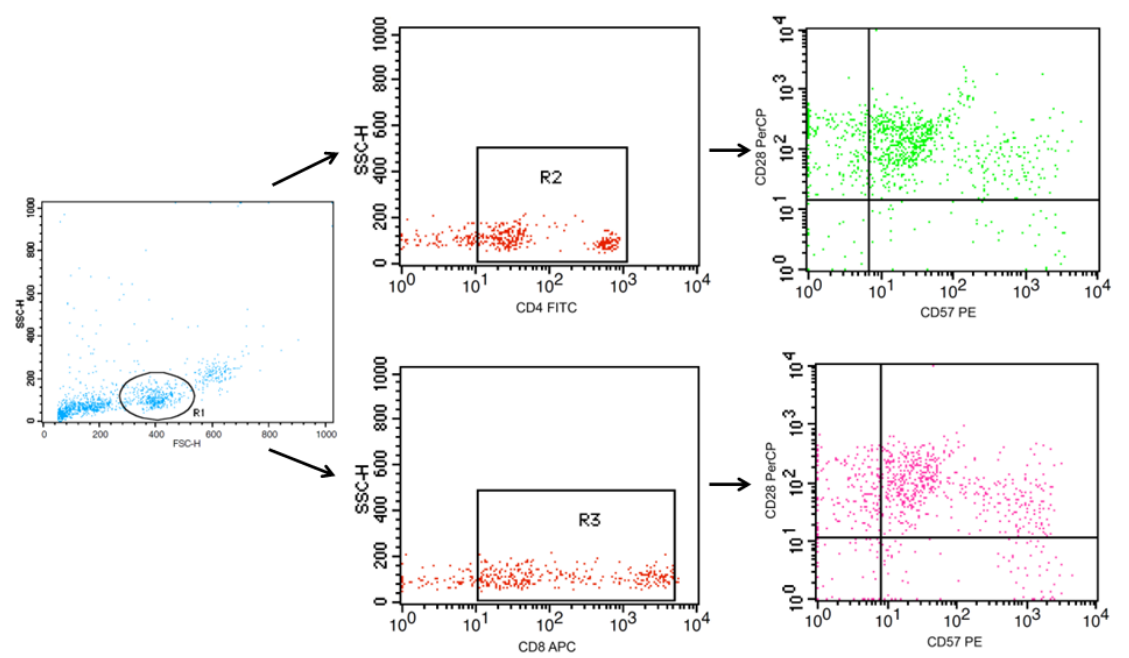
Figure 3. Representative dot plots of a flow cytometry panel used for the detection of both CD4+ T cells and CD8+ T cells associated with the profile naïve (CD28+CD57 − ), double-positive (CD28+CD57+), and senescent (CD28-CD57-). PBMCs were stained with Abs recognizing CD4, CD8, CD28, and CD57 and were analyzed by flow cytometry, with the gating as indicated.